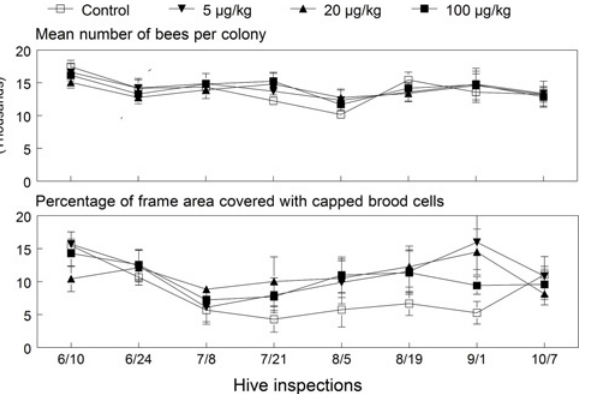
Fig 5. Mean ( ± SE) colony size and percentage of capped brood cells in the 2010 colonies exposed to untreated or imidacloprid-spiked diet patties for 12 weeks (May 27 to August 19). ANOVA results for bees (dose: F (3, 23.7) = 0.04, p = 0.988; date: F (7, 165) = 7.69, p < 0.001; interaction: F (21, 165) = 3.89, p = 0.608) and brood (dose: